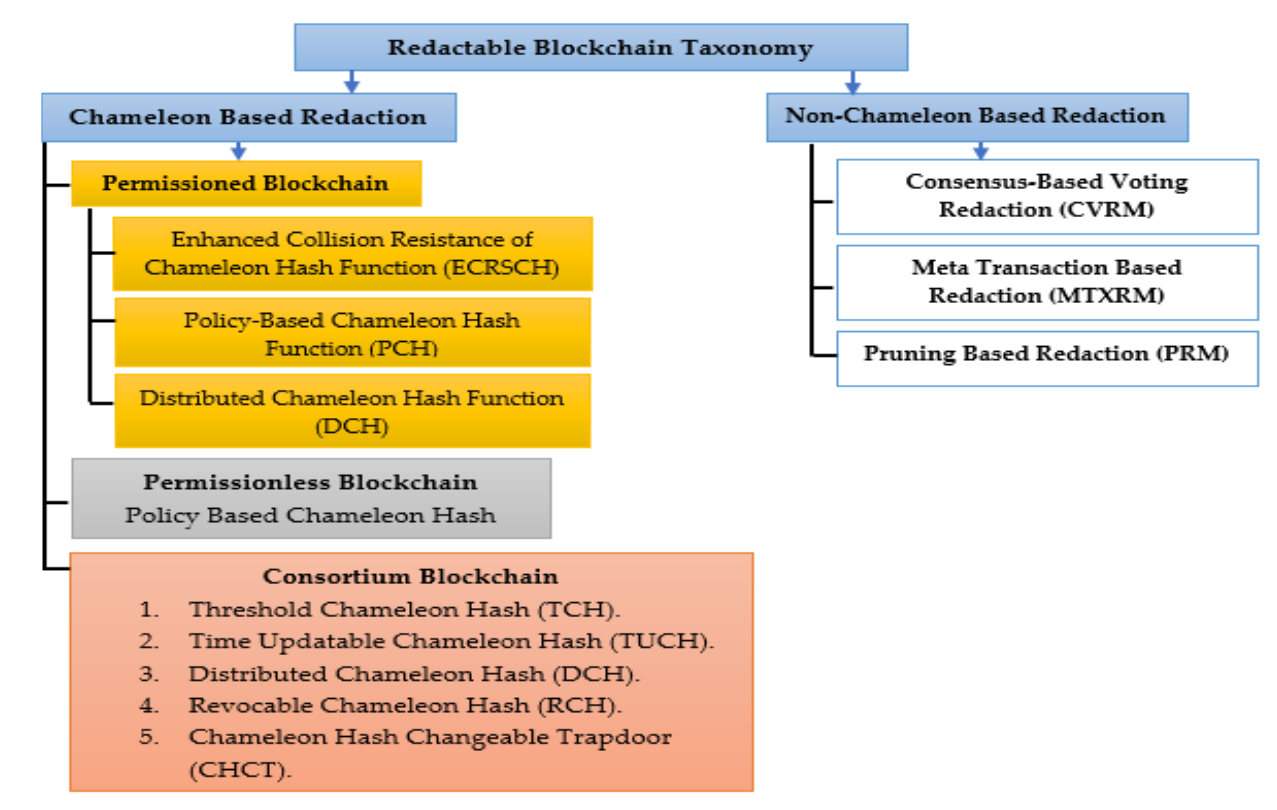
Figure 4. Paper taxonomy analyzing redactable blockchain state of